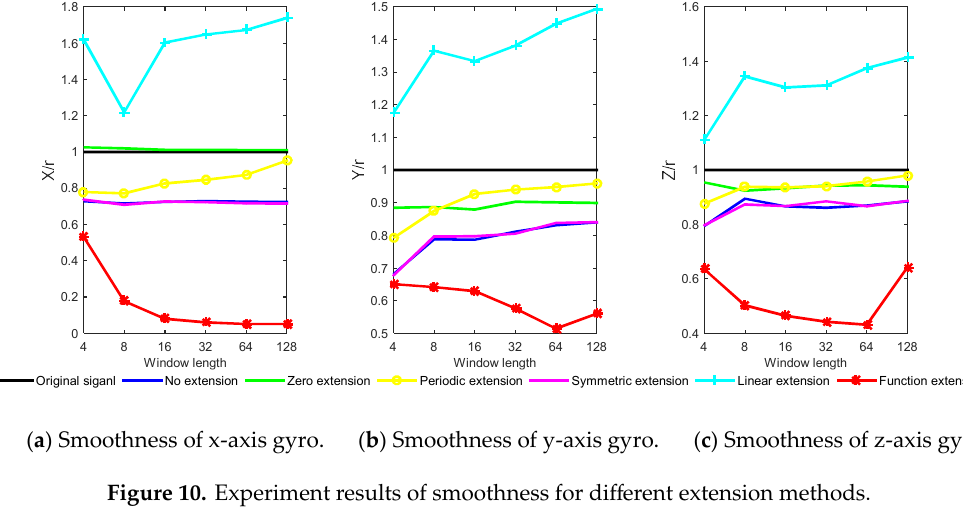
Figure 10. Experiment results of smoothness for different extension methods.